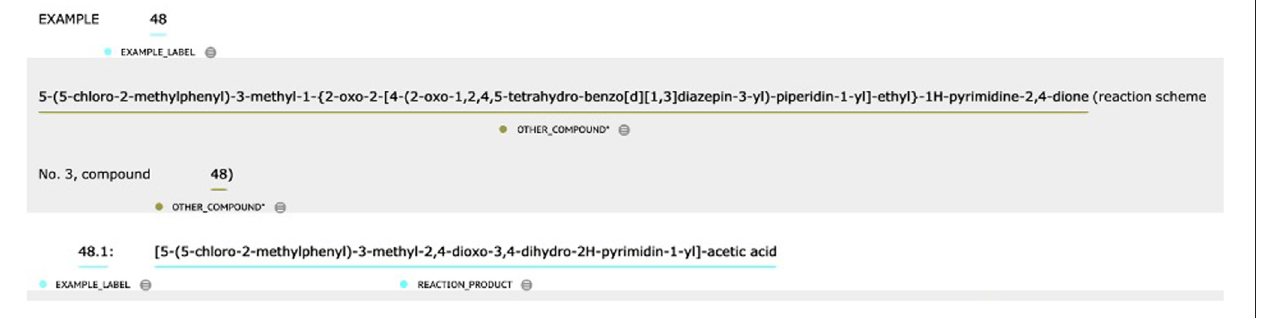
FIGURE 3 | An example of a text snippet with hierarchical steps of chemical